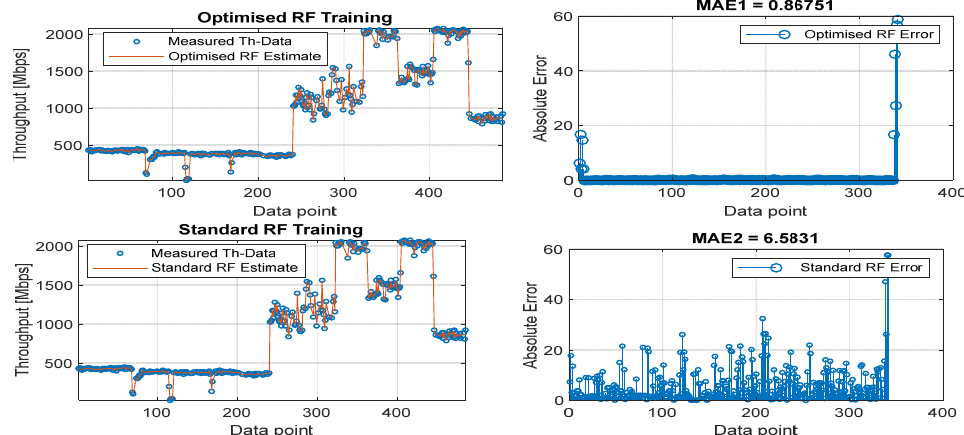
Figure 10. Predicted throughput quality performance of the proposed RF-LS-BPT model and standard RF model at 75 m distance.